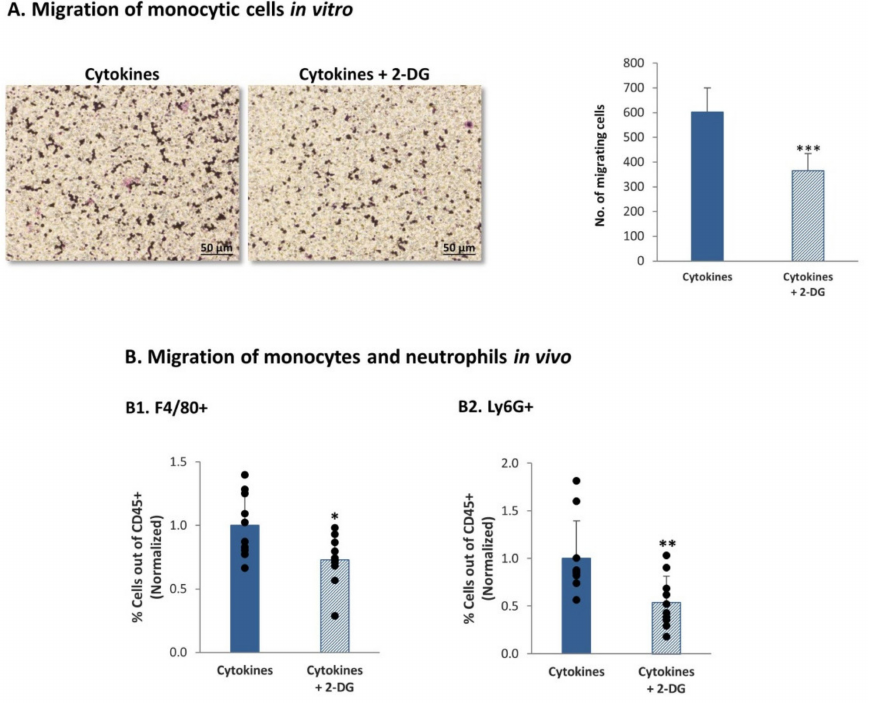
Figure 11. Continuous TNF α + IL-1 β stimulation of TNBC cells leads to a glycolysis-dependent migration of monocytes and neutrophils in vivo ( A ) Migration of monocytic THP-1 cells in response to CM of MDA-MB-231 cells undergoing persistent stimulation by TNF α + IL-1 β . MDA-MB-231 cells that were continuously stimulated by TNF α + IL-1 β (as described in Figure 1) were treated with the inhibitor of glycolysis (2-DG) or its solubilizer. CM free of exogenously-added cytokines or 2-DG were collected (as described in materials and methods section) and were used in transwell migration assays of THP-1 cells. The figure demonstrates representative images of the migrating cells and quantitative analyses of migrating cells, in a representative experiment of n > 3. *** p < 0.001. Bar, 50 µ m. ( B ) Migration of monocytes and neutrophils in vivo. MDA-MB-231 cells that were continuously stimulated by TNF α + IL-1 β (as described in Figure 1) were treated with the inhibitor of glycolysis (2-DG) or its solubilizer, as described in the materials and methods section. CM free of exogenously-added cytokines or 2-DG were collected (as described in materials and methods section), filtered and injected with matrigel to form plugs in female Balb/C mice; Plugs were removed 7 days later, and infiltrating cells were recovered from the plugs and analyzed by flow cytometry. The percentage of F4/80+ cells (monocytes) ( B1 ) and of Ly6G+ cells (neutrophils) ( B2 ) out of CD45+ cells was determined. The results are of 10 mice in each group, obtained in two independent experimental repeats. Average ± SD of normalized values in n = 10 (in each group) are presented; the percentage of cells in plugs containing CM of cytokine-treated cells, without 2-DG, were averaged and were given the value of 1. ** p < 0.01, * p <